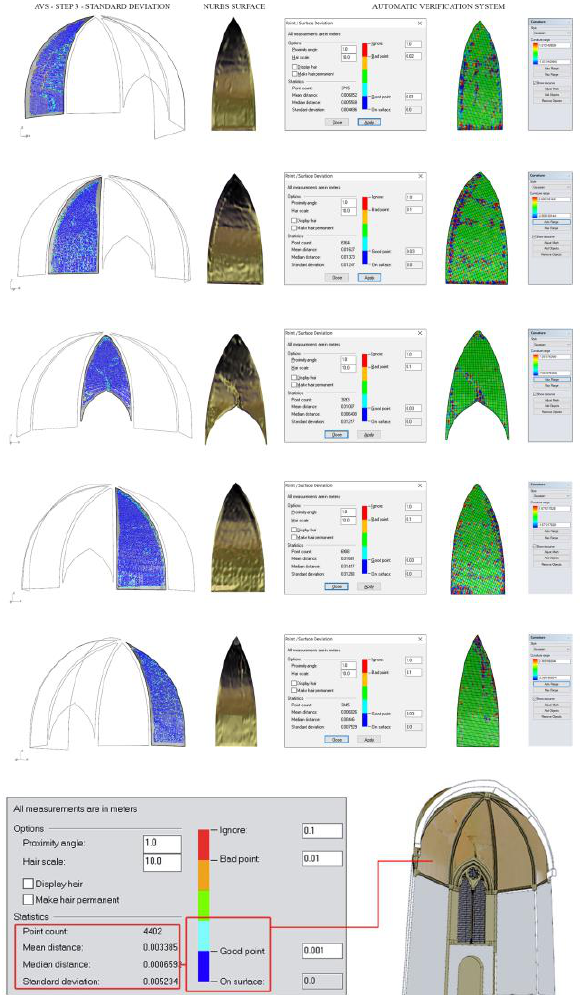
Figure 4 The AVS of the umbrella vault provided for a GOA of 5/10